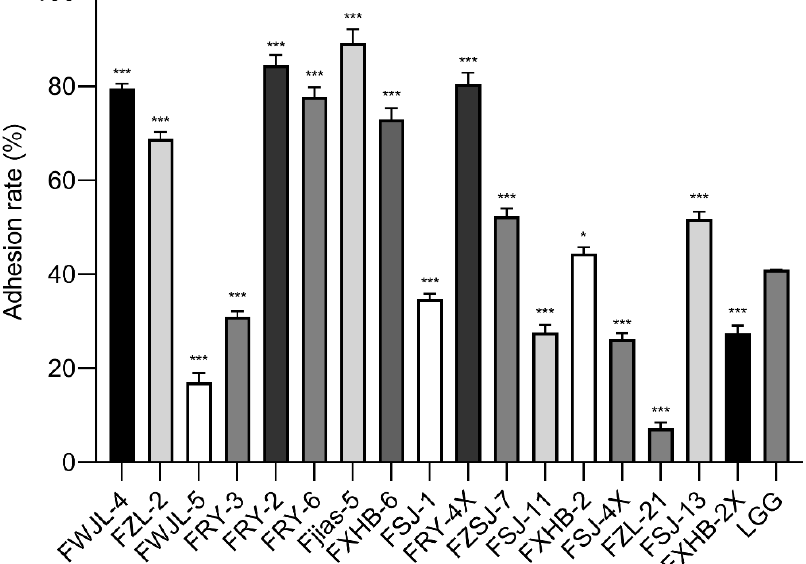
Figure 3. The adhesion ability of the selected strains to Caco-2 cells in vitro. All data were expressed as mean ± SD ( n = 3 independent experiments). Statistical significance was defined as * p < 0.05; *** p < 0.001. Reported statistical significance refers to comparisons with LGG.